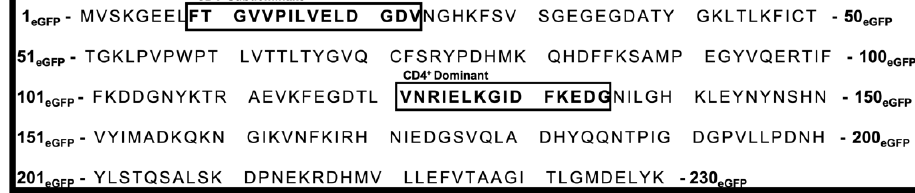
Figure 6. Enhanced green fluorescent protein (eGFP) epitope maps showing dominant and subdom- inant peptides for CD8 + and CD4 + T cell responses in C57BL/6 and BALB/c mice. C57BL/6 and BALB/c mice were vaccinated with Ad-eGFP, followed by a VSV-eGFP boost, and eGFP-specific re- sponses were analyzed at the peak of the response (five days post-boost) using peptide re-stimulation and intracellular flow cytometry staining. Shown is the complete eGFP amino acid sequence with boxes that show the peptides that contained the immunodominant and subdominant epitopes for ( a ) CD8 + and ( b ) CD4 + T cells in C57BL/6 mice. Similarly, peptides containing eGFP-derived ( c ) CD8 + and ( d ) CD4 + T cell epitopes in BALB/c mice are shown. Sequences containing the complete epitope are boxed with a bolded line. Conversely, sequences containing partial epitopes are boxed in a thin dotted line. Data were derived from a minimum of three mice per